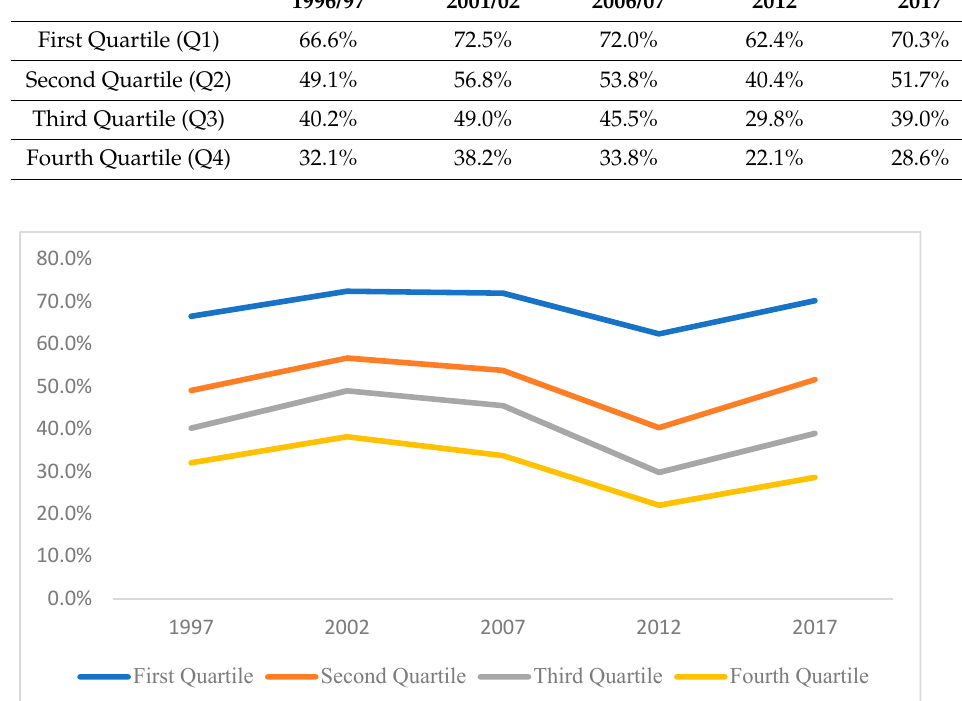
Figure 6. Trend in percentage of households with zero OOPHE by income quartiles.